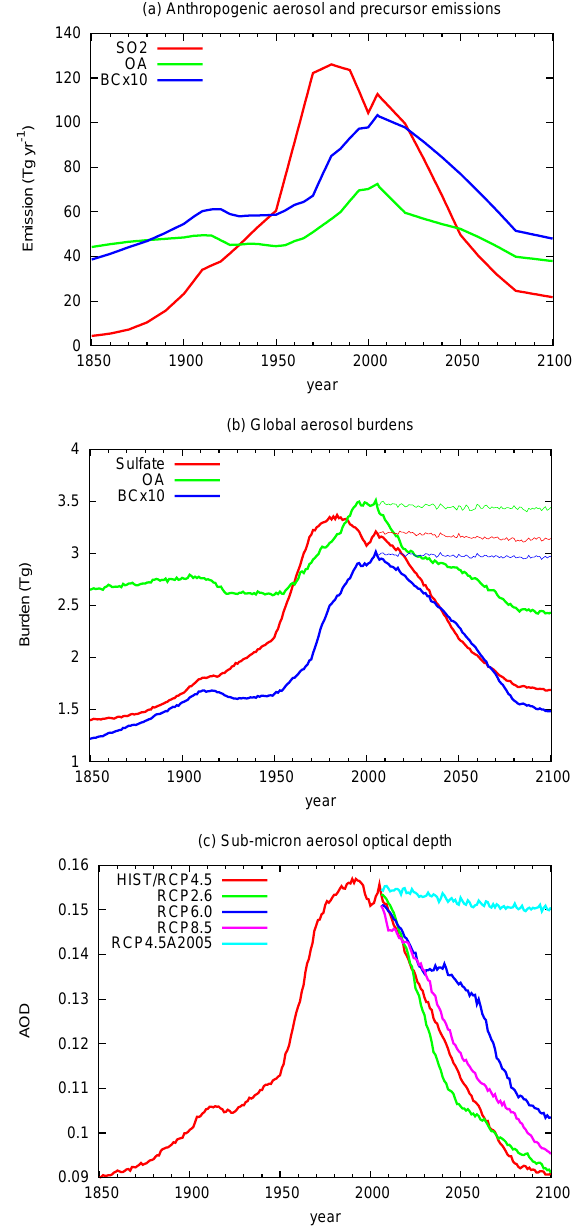
Fig. 1. Time series of global aerosol properties: (a) annual anthro- pogenic emissions of SO 2 (red), OA (green) and BC (blue, mul- tiplied by 10), shown as teragrams of species. (b) Annual-mean global aerosol burdens from HIST (1850–2005) and RCP45 (2006– 2100), shown as thick lines: sulfate (red), OA (green) and BC (blue, multiplied by 10). Corresponding burdens from RCP45A2005 (2006–2100) are shown as thin lines. (c) Annual-mean sub-micron clear-sky AOD at 550nm from HIST and RCP45 (red line), com- prising the sum of AOD from sulfate, OA and BC. For compari- son, AODs for 2006–2100 are also shown for RCP45A2005 and the other standard